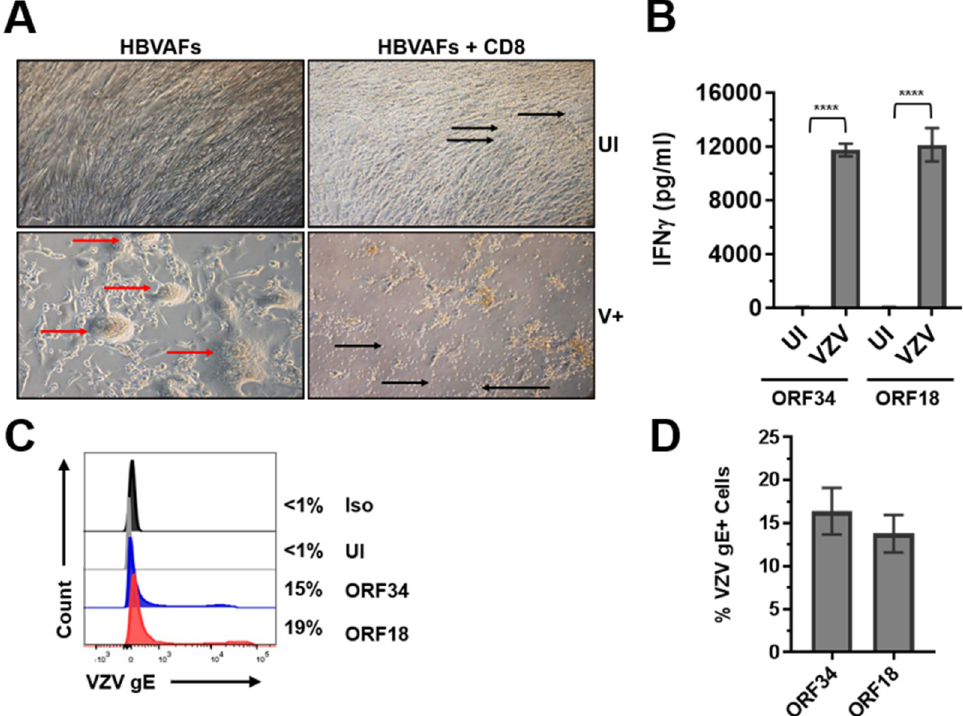
Fig 7. VZV ORF34- and ORF18-specific CD8 + T cells recognize VZV-infected HBVAFs and are prone to infection. (A) HBVAFs were uninfected- (UI) or VZV-infected (V+) for 72 h and then cultured alone or with VZV ORF34- or ORF18-specific CD8 + T cells for an additional 48 h. After 48 h of co-culturing, phase contrast microscopy images were taken. Black arrows represent CD8 + T cells and red arrows represent VZV-infected region of HBVAFs. Magnification, X100. Representative images of 4 independent experiments. (B) Cell culture supernatants were harvested 24 h after co- culturing VZV ORF34- or ORF18-specific CD8 + T cells with UI- or VZV-infected HBVAFs/HFLs and analyzed for IFN γ levels using ELISA. Results representative of 8 independent experiments with bar graphs representing average IFN γ levels (pg/ml) ± SEM. Statistical significance was determined using the unpaired Student’s t -test. ���� P < 0.0001. (C) Representative flow cytometry analyses of VZV gE expression in live CD8 + T cells 48 h after co-culturing. Black histograms = Isotype control (Iso), grey = UI cells, blue histograms = VZV-infected ORF34 cells, red histograms = VZV- infected ORF18 cells. Numbers represent % of cells VZV gE+. (D) Summary of flow cytometry analyses of % VZV gE + cells in live CD8 + ORF34- or ORF-18 specific T cells. Results representative of 19 and 16 independent experiments from VZV ORF18- and ORF34-specific CD8 + T cells, respectively. Bar graphs represent average % of cells VZV gE+ ±